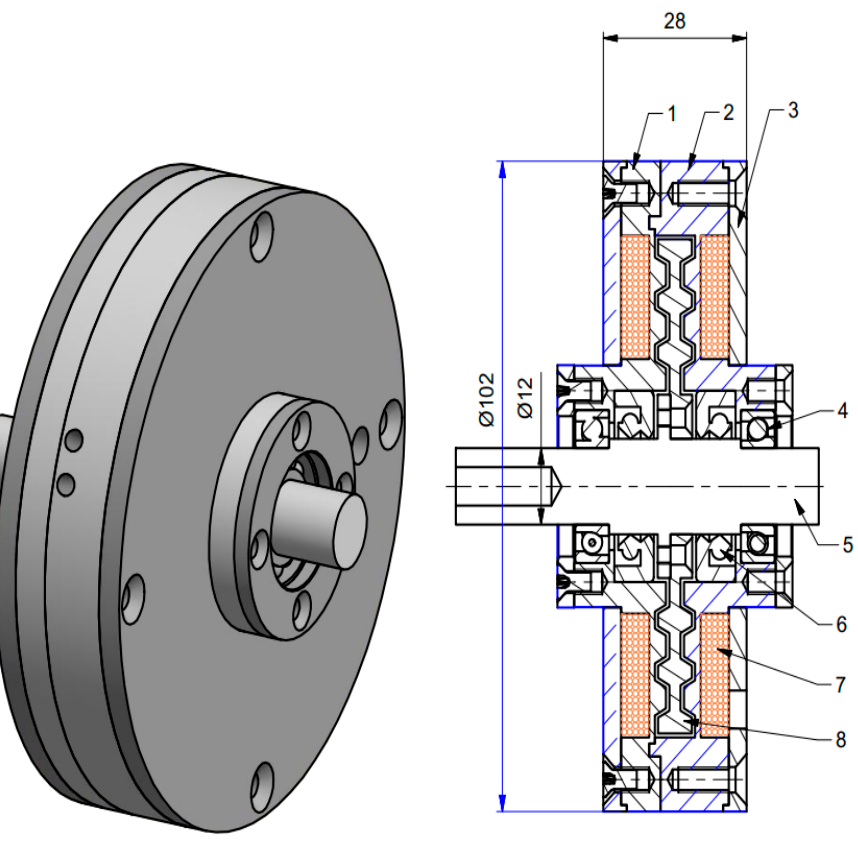
Figure 7. Assembly design of the rotary MR brakes.